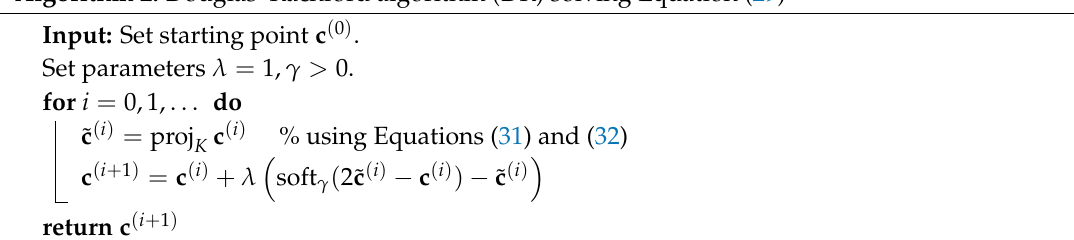
Algorithm 2: Douglas–Rachford algorithm (DR) solving Equation